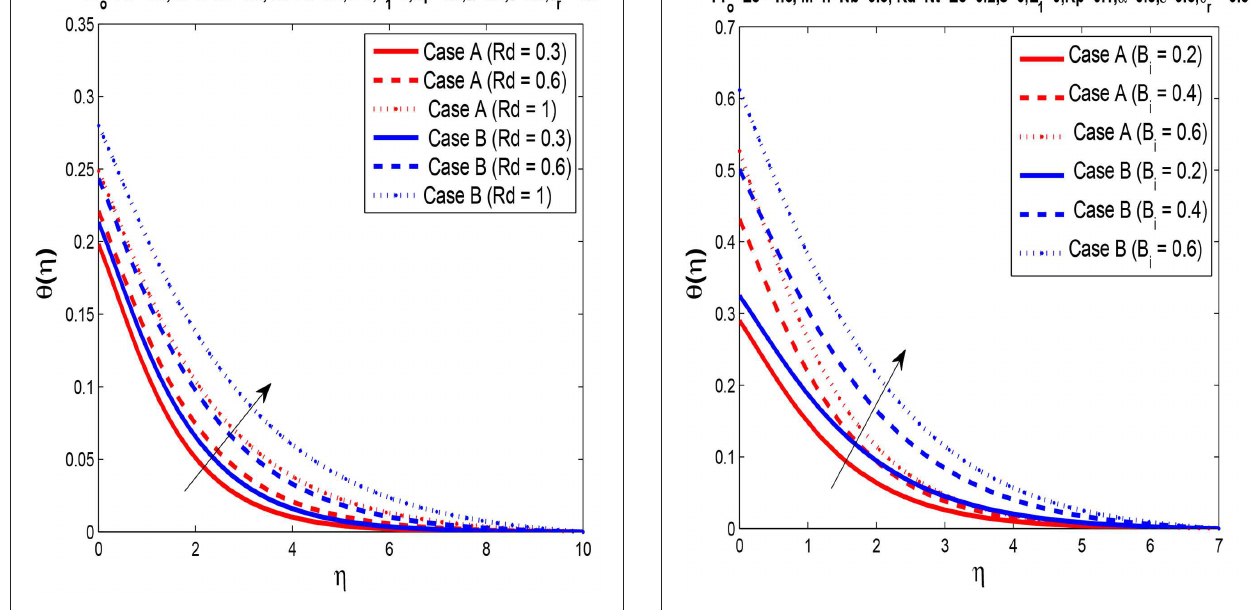
FIGURE 8 | Temperature profile θ ( η ) for different values of B i .